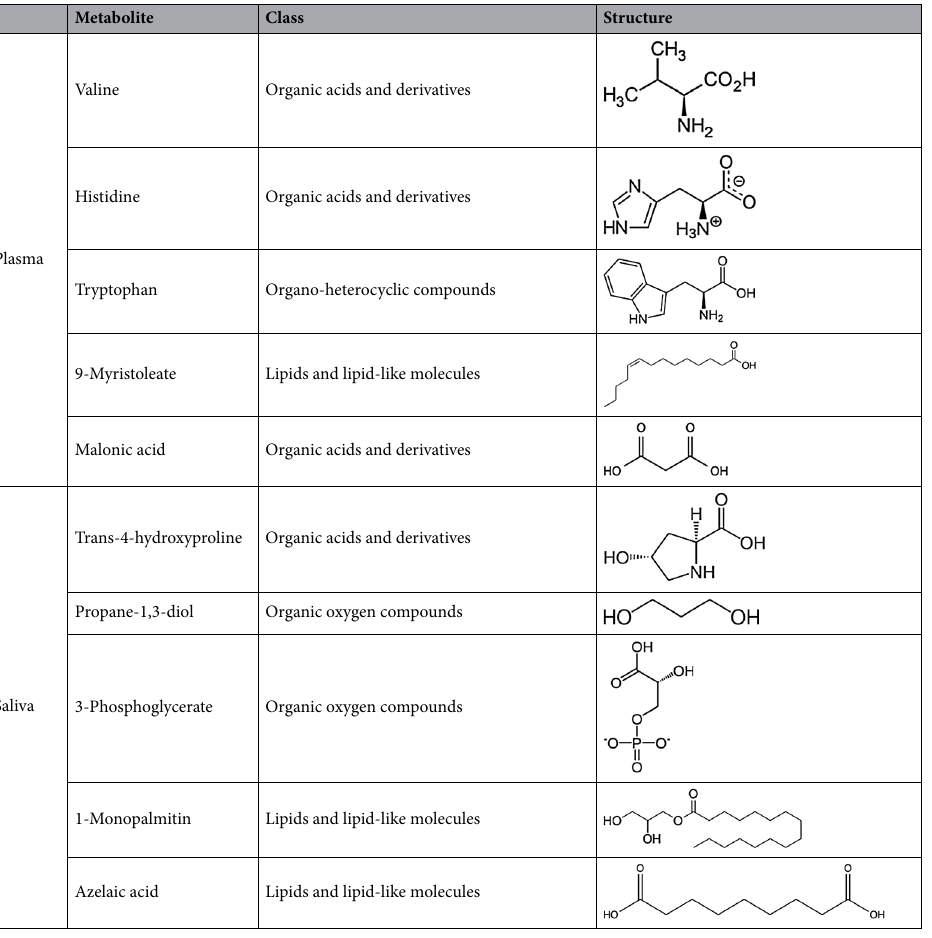
Table 1. Top five metabolites identified by variable importance score in the PLS-DA model for cancer vs control in both plasma and